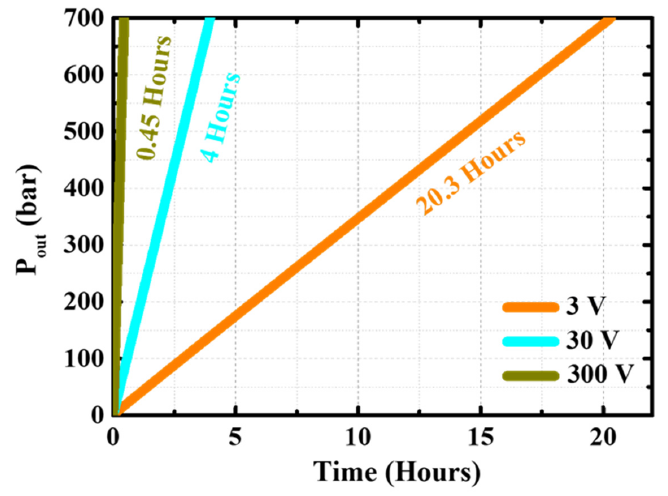
Figure 12. Time required to reach a pressure of 700 bar at different voltages .